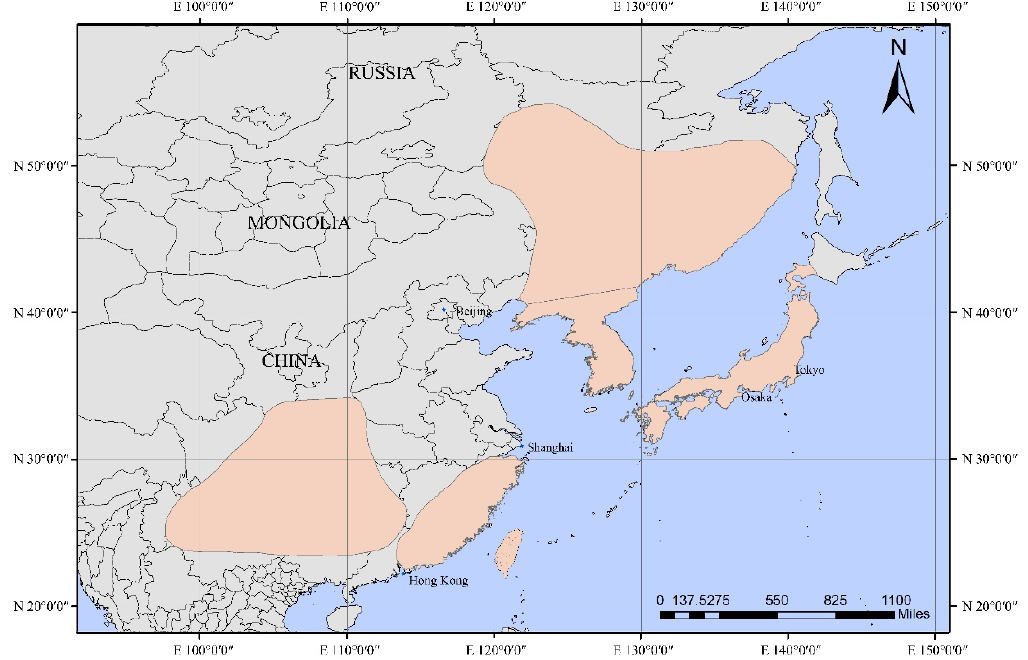
Figure 1. The distribution map of the yellow-throated bunting. The orange area is the marked spe- cies distribution. Distribution data were obtained from the IUCN Red List of Threatened Species Version 2018-2. (https://www.iucnredlist.org. Accessed on 5 January 2022.)